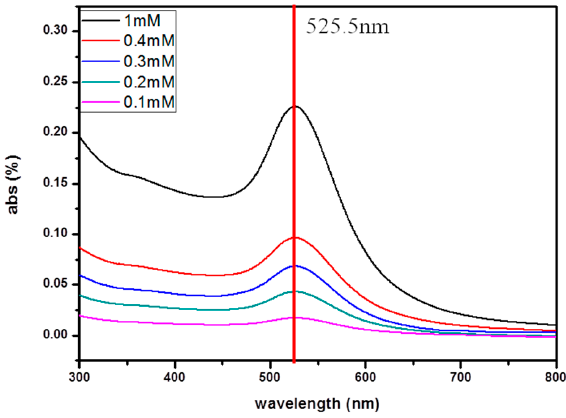
Figure 7. UV-vis spectra of AuNPs in different concentrations and the corresponding calibration curves.